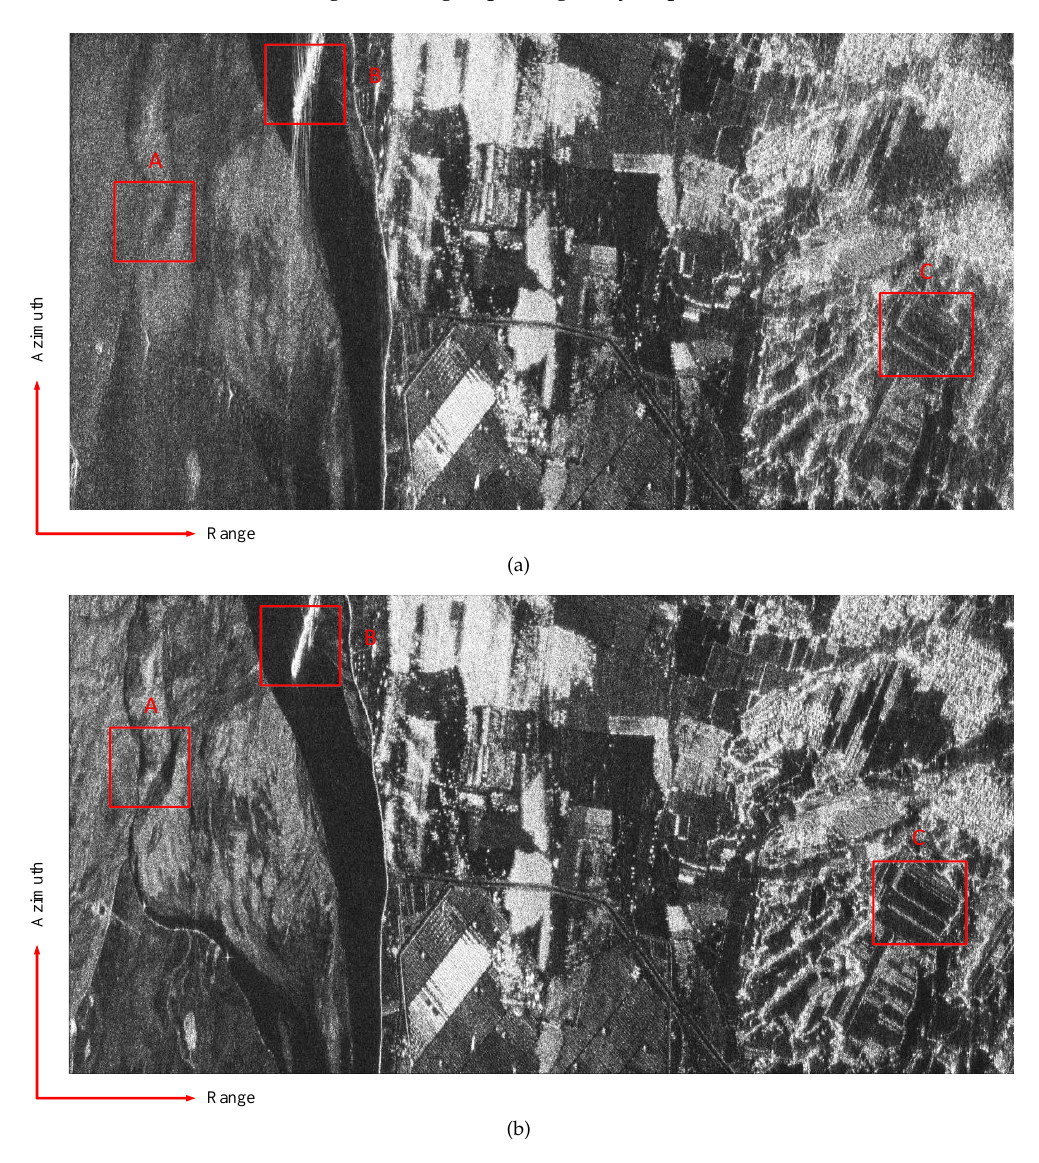
Figure 10. Comparison of imaging results of real data processed by different algorithms. ( a ) Conventional generalized chirp scaling algorithm (GCSA). ( b ) Proposed